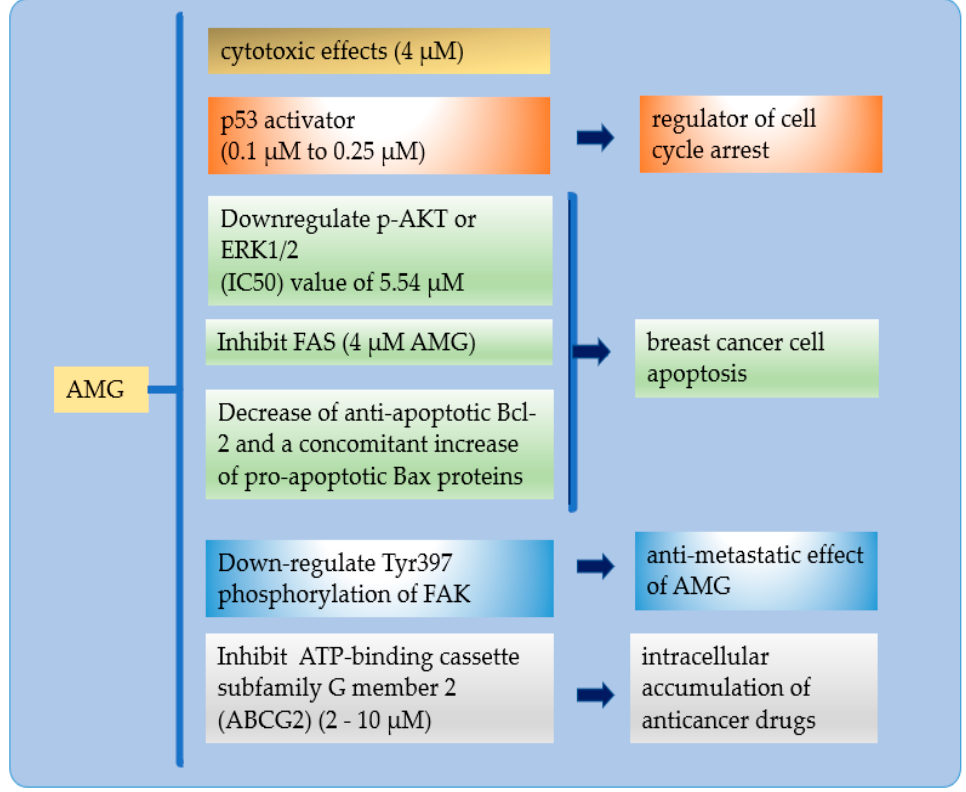
Figure 3. Hallmark mechanism of AMG in BC.